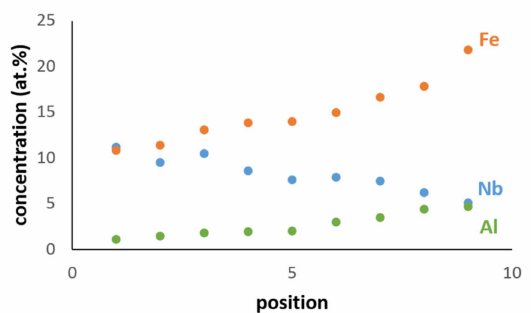
Figure 4. Al, Fe, and Nb concentrations from near the bulk (center) of one TM 6 Si 5 grain to near its edge. Center and edge correspond to positions zero and ten,